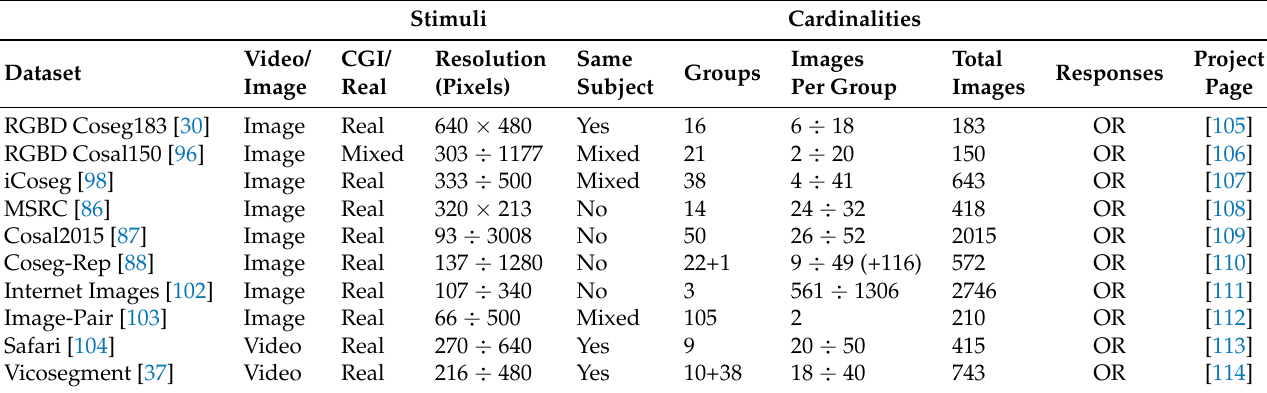
Table 7. Selected datasets for co-saliency estimation with corresponding characteristics (OR = Object Regions).